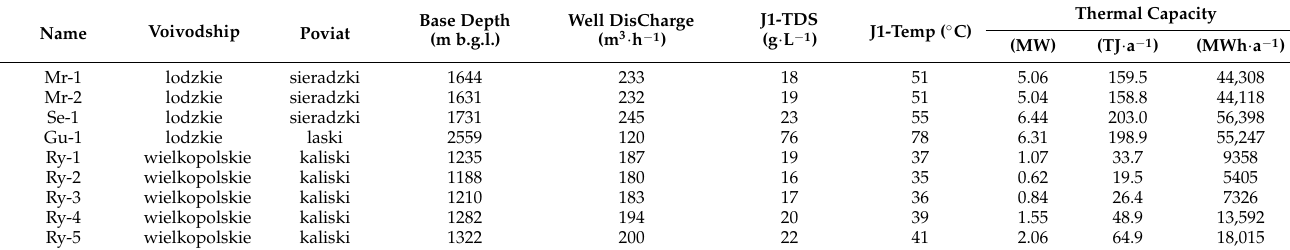
Table 4. Geothermal and energetic data of the selected locations.